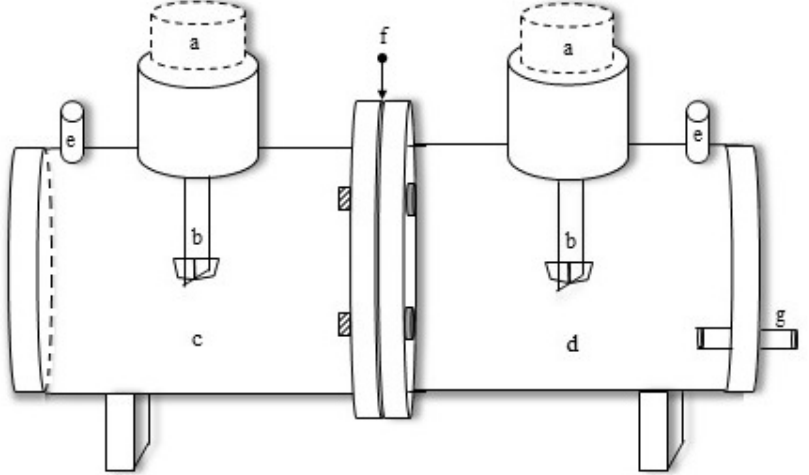
Figure 1. Membrane reactor. a Variable speed stirring motors; b stirrers; c feed chamber; d strip chamber; e sampling port; f oil supported membrane; g wastewater outlet.